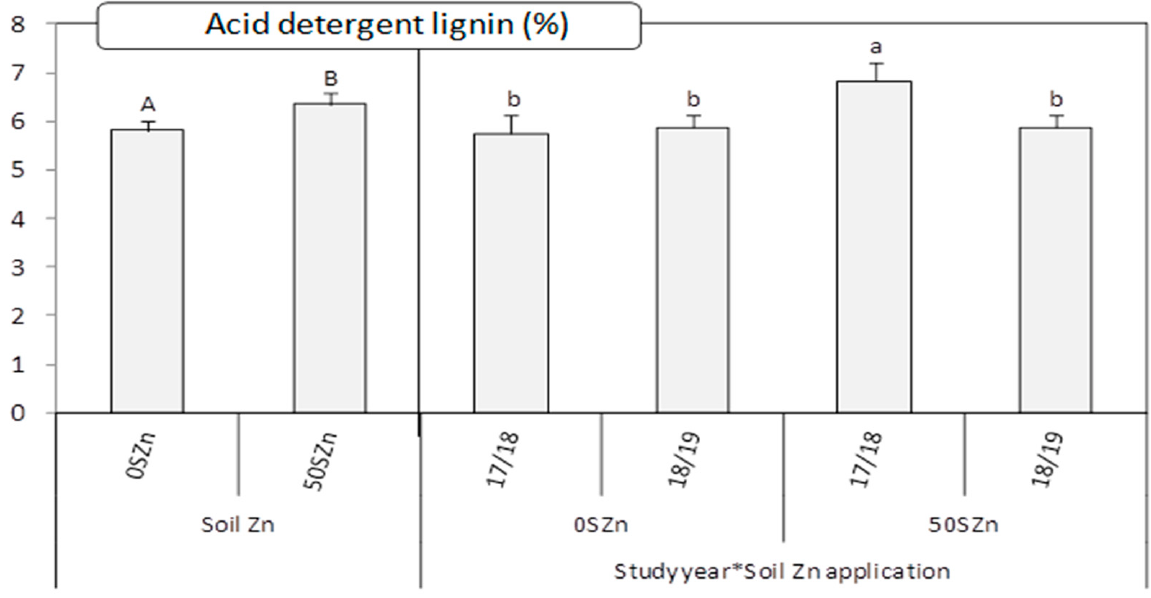
Figure 5. Acid detergent lignin for straw as affected by the main effect ‘Soil Zn application (S)’ and by the interaction ‘Study year (Y)*S’. Charts indicate means ( n = 4) and error bars indicate standard error. Within each factor, different letters mean significant differences between means according to LSD test ( p ≤ 0.05). To make the differences clearer, a different set of letters was assigned to each factor (lowercase letters for ‘Y*S’ and uppercase letters for ‘S’).